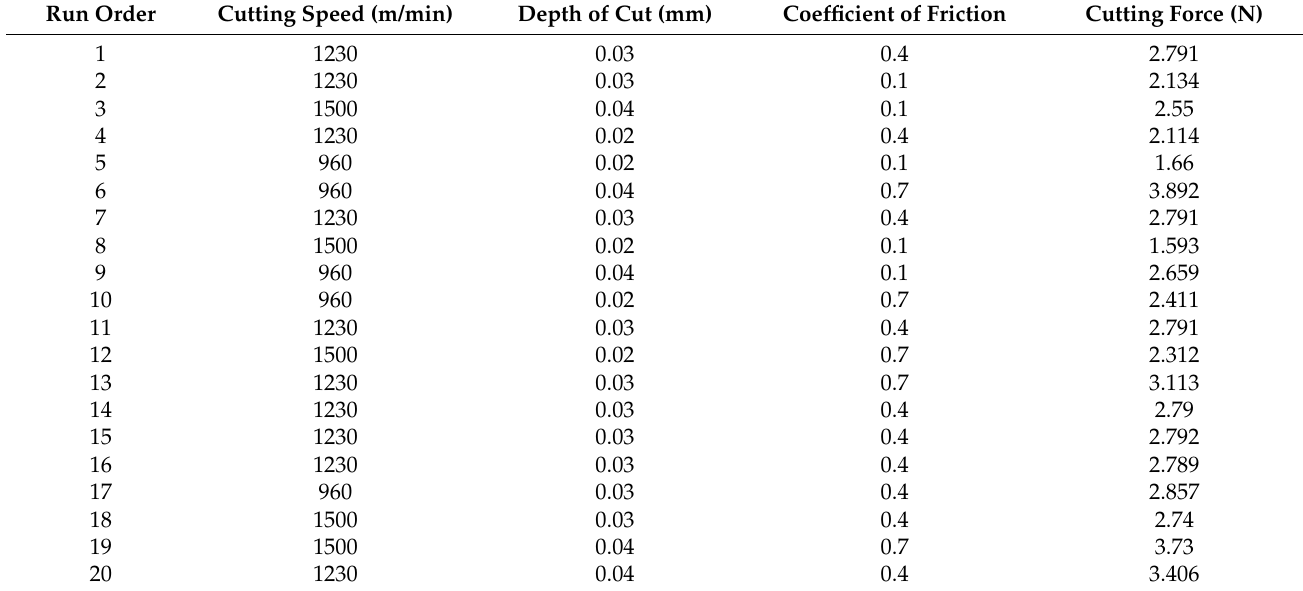
Table 3. Design layout and experimental results.